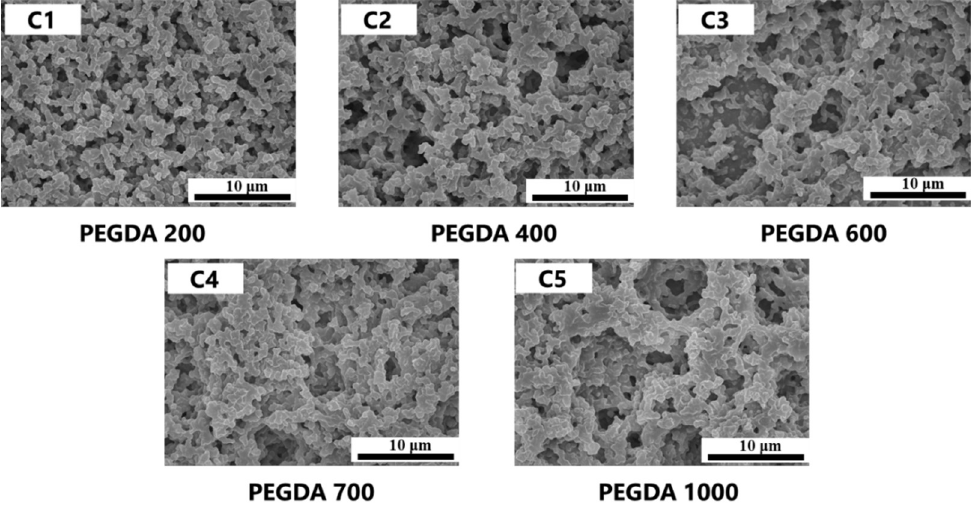
Figure 5. Microphotography of PDLC films with different monomers: C1 (PEGDA 200), C2 (PEGDA 400), C3 (PEGDA 600), C4 (PEGDA 700), and C5 (PEGDA 1000). 400), C3 (PEGDA 600), C4 (PEGDA 700), and C5 (PEGDA